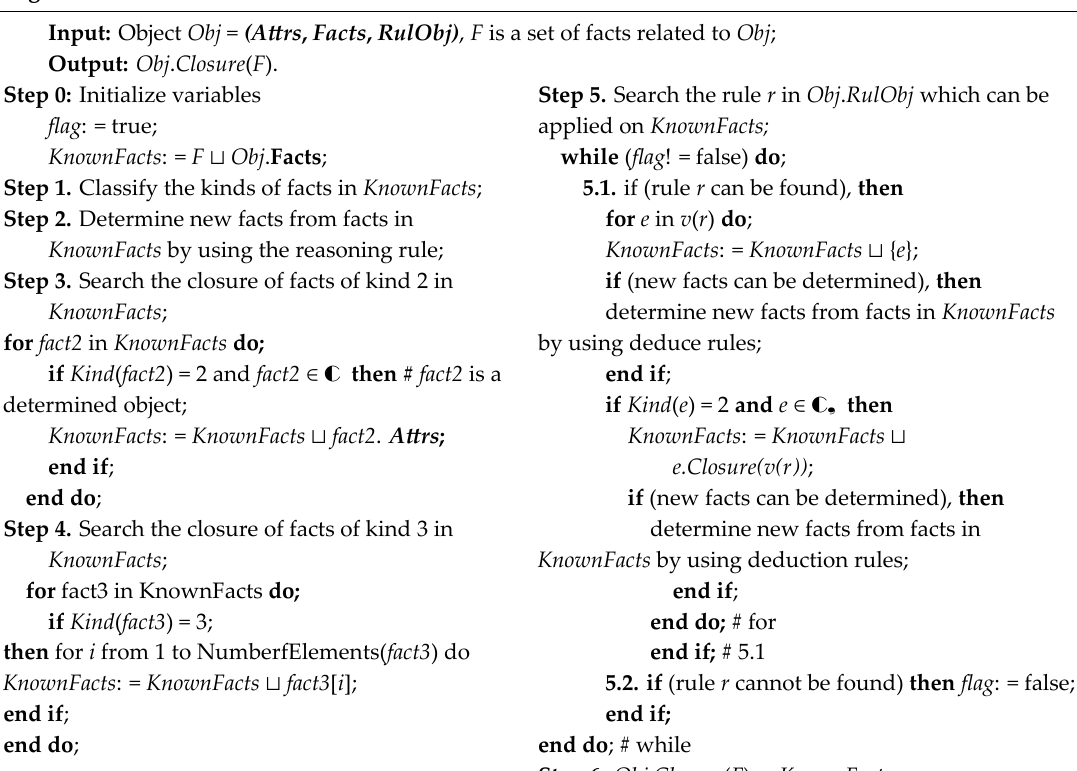
Algorithm 1. Determine the closure of a set of